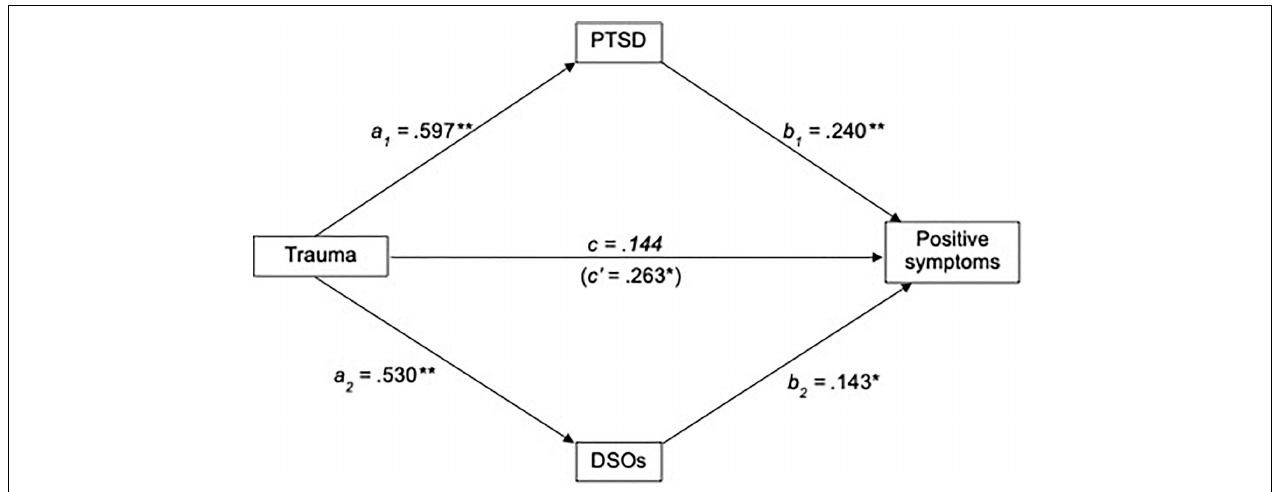
FIGURE 2 | Standardized regression coefficients for the relationship between trauma and positive symptoms, mediated by PTSD and DSOs, including dataset as a covariate. ** p < 0.005; * p < 0.05. PTSD, Post-traumatic stress disorder; DSOs, Disturbances of self-organization.